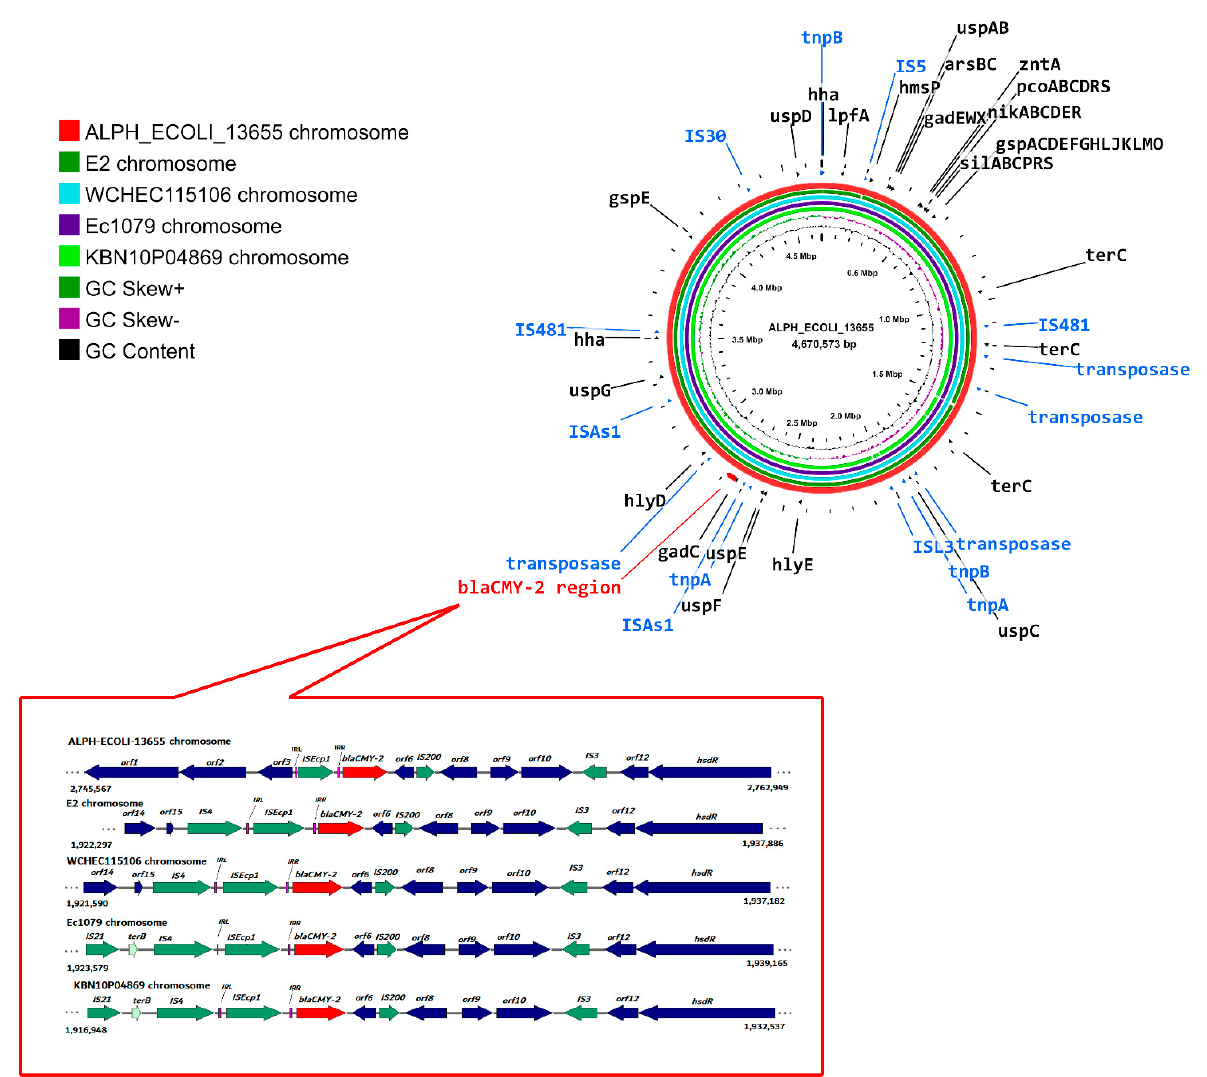
Figure 6. CGView circular comparison of ALPH_ECOLI-13655 chromosome with most similar bla CMY-2 -containing chromosomes from the NCBI database with an expanded view of the bla CMY-2 - containing region, generated by SnapGene. The innermost circles show the chromosome coordinates, GC content (black), and GC skew (dark green and magenta). Circles from inside to outside correspond to the KBN10P04869 (CP026473.1), WCHEC115106 (CP043334.1), Ec1079 (CP081306.1), E2 (CP048915.1), and ALPH_ECOLI-13655 chromosomes. Virulence-associated determinants, inser- tion sequences and transposases, and the bla CMY-2 -containing region are indicated in black, blue, and red, respectively. Abbreviations: IRL (CCTAGATTCTACGT) and IRR (ACGTGGAATTTAGG) are left and right inverted repeats of IS Ecp1 , respectively.